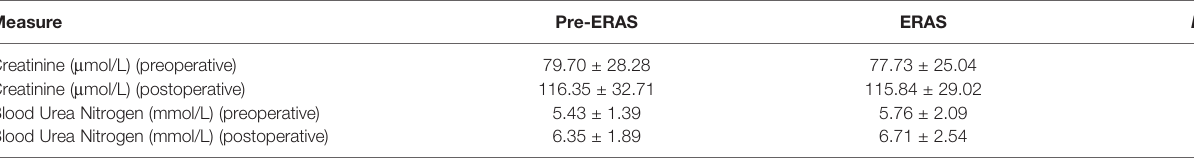
TABLE 3 | Comparison of the patients ’ renal function